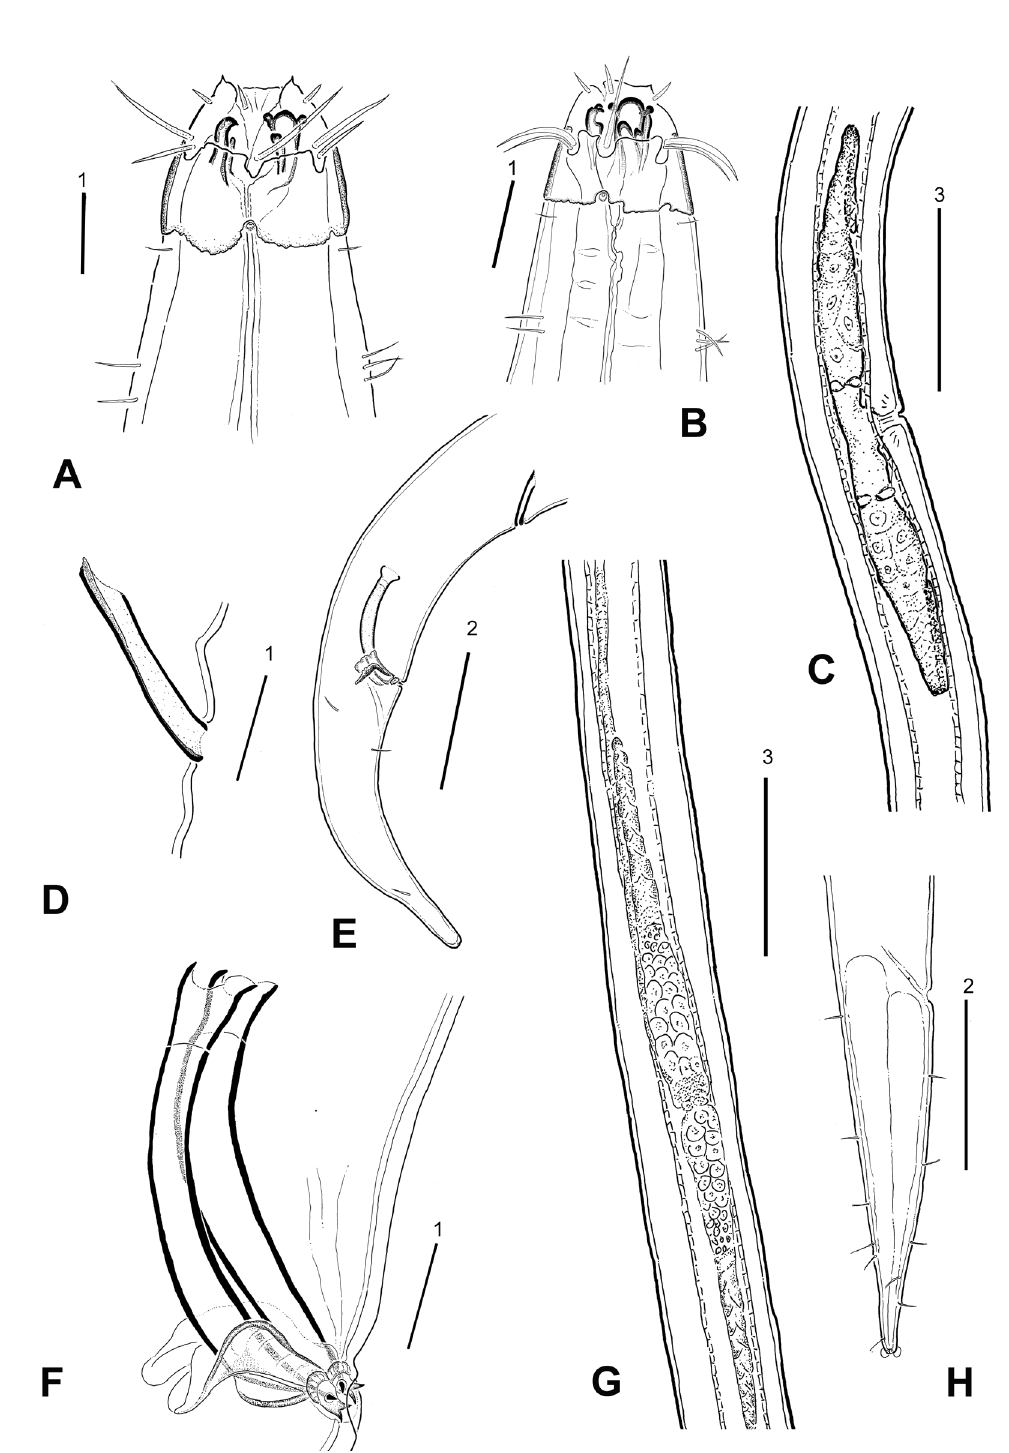
Fig. 2. Mesacanthion bifidum sp. nov. A . Cephalic sense organs on anterior end of female paratype (CNP- NEM 983). B . Cephalic sense organs on male holotype (CNP-NEM 936). C . Female paratype (CNP- NEM 983) showing vulva and gonadal apparatus. D . Precloacal supplement organ of male holotype (CNP-NEM 936). E . Posterior end of male holotype (CNP-NEM 936). F . Copulatory apparatus, spicules and gubernaculum of male holotype (CNP-NEM 936). G . Gonads of male holotype (CNP-NEM 936). H . Posterior end of female paratype (CNP-NEM 983). Scale bars: 1 = 20 μm; 2 = 100 μm; 3 = 200